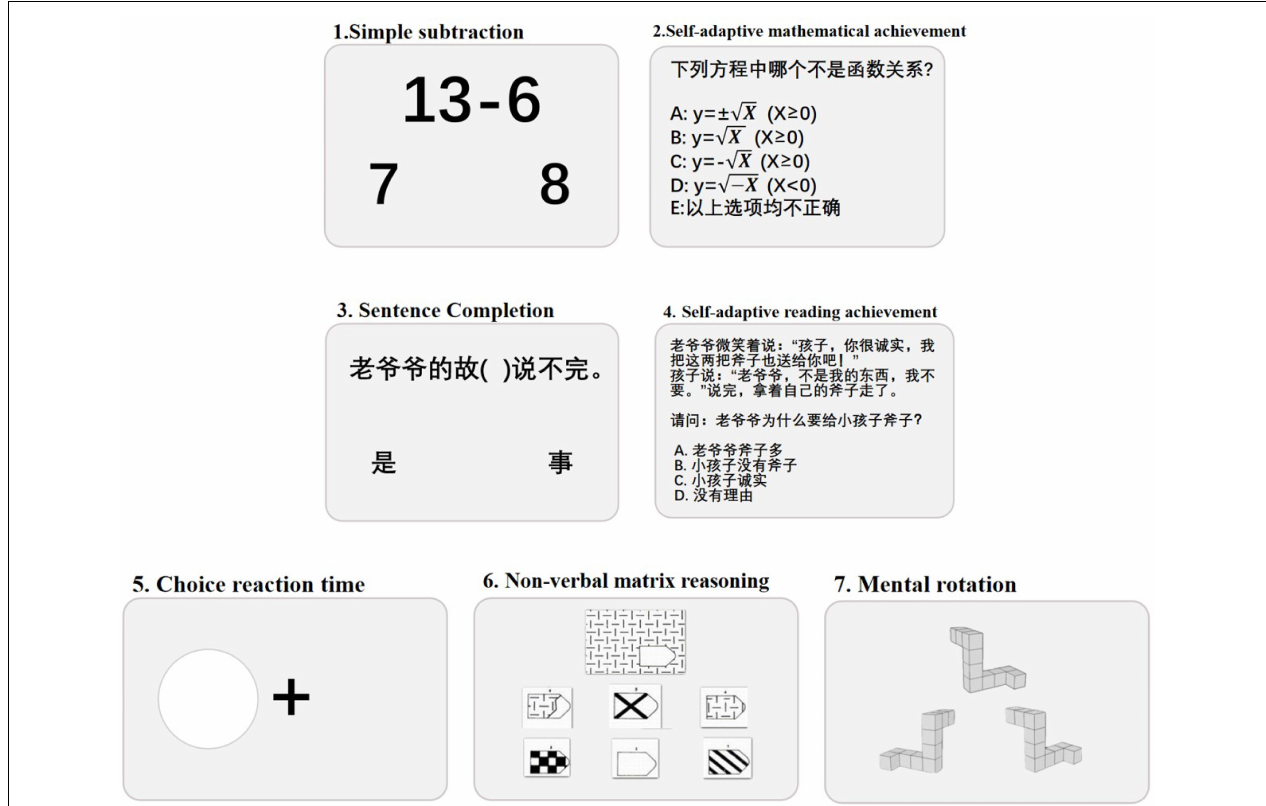
FIGURE 1 | Schematic representation of tests used in the current